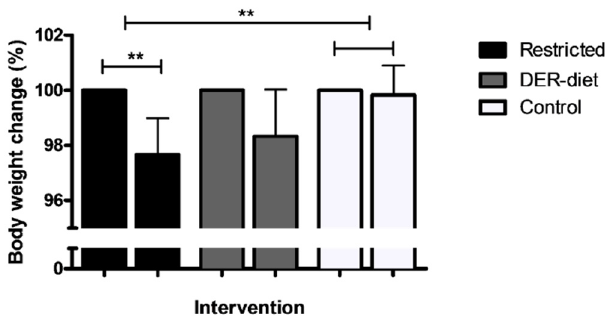
Figure 3. Body weight changes in the three dietary intervention groups. Patients on the restricted diet lost an average of 2.5% of their body weight, corresponding to 2.4 ± 1.4 kg; This body weight loss was significantly greater than in the control group, which showed no change; The DER ‐ diet resulted in a 1.7% loss in body weight (1.5 ± 1.4 kg), which was not significantly different than the two other groups; Changes are shown as percentages compared to the body weight at baseline; ** p < 0.01. Bars represent the standard error of the mean. DER = daily energy requirements.